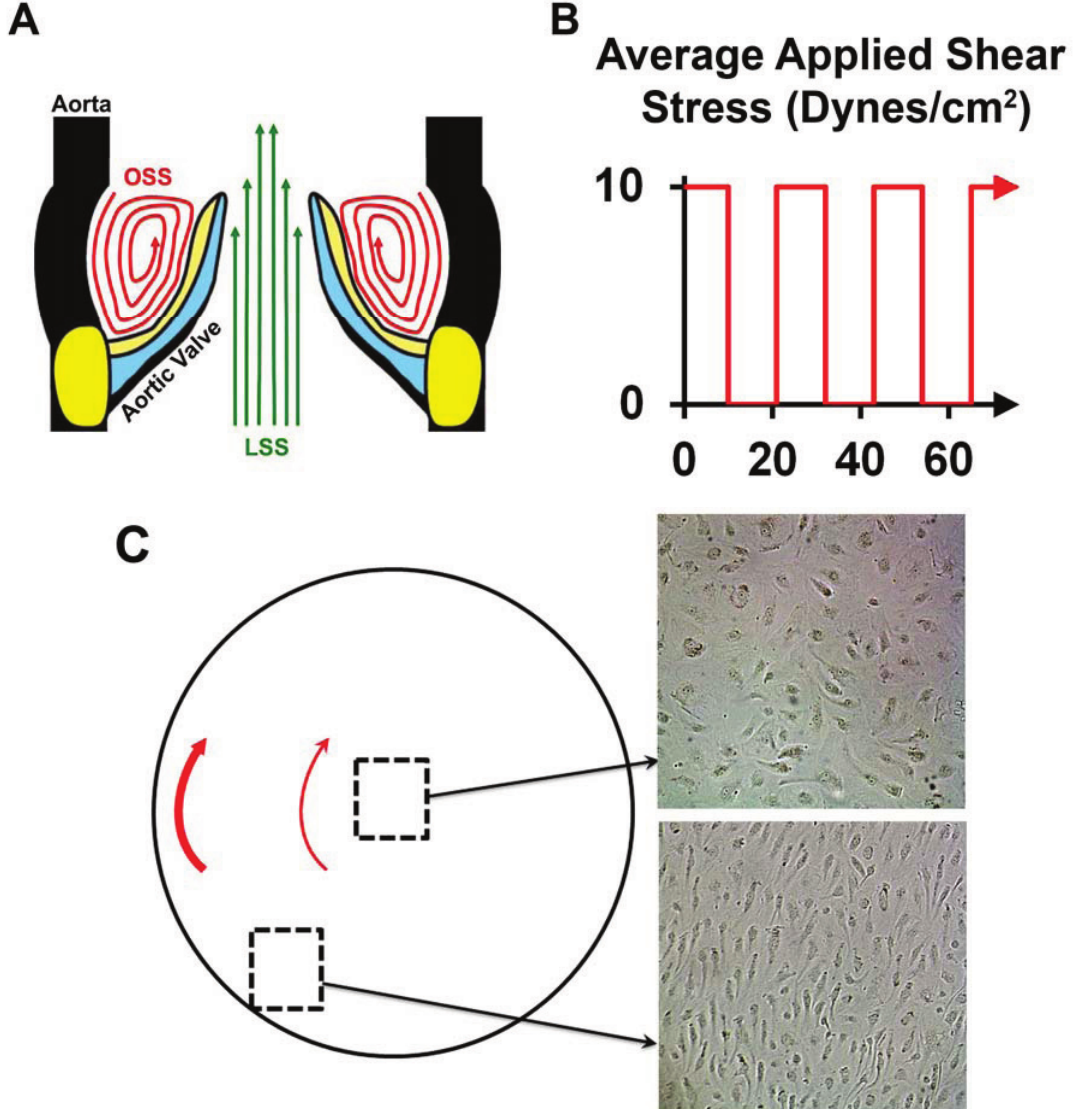
Figure 1. Oscillatory shear stress (OSS) experimental approach. ( A ) Regional aortic valve anatomy and hemodynamics. The aortic valve is stratified into fibrosa (yellow), spongiosa (blue), and ventricularis (black) layers. The fibrosa (arterial side of the cusp) is collagen-rich, experiences OSS (red arrows), and is the primary site of calcific lesion formation.